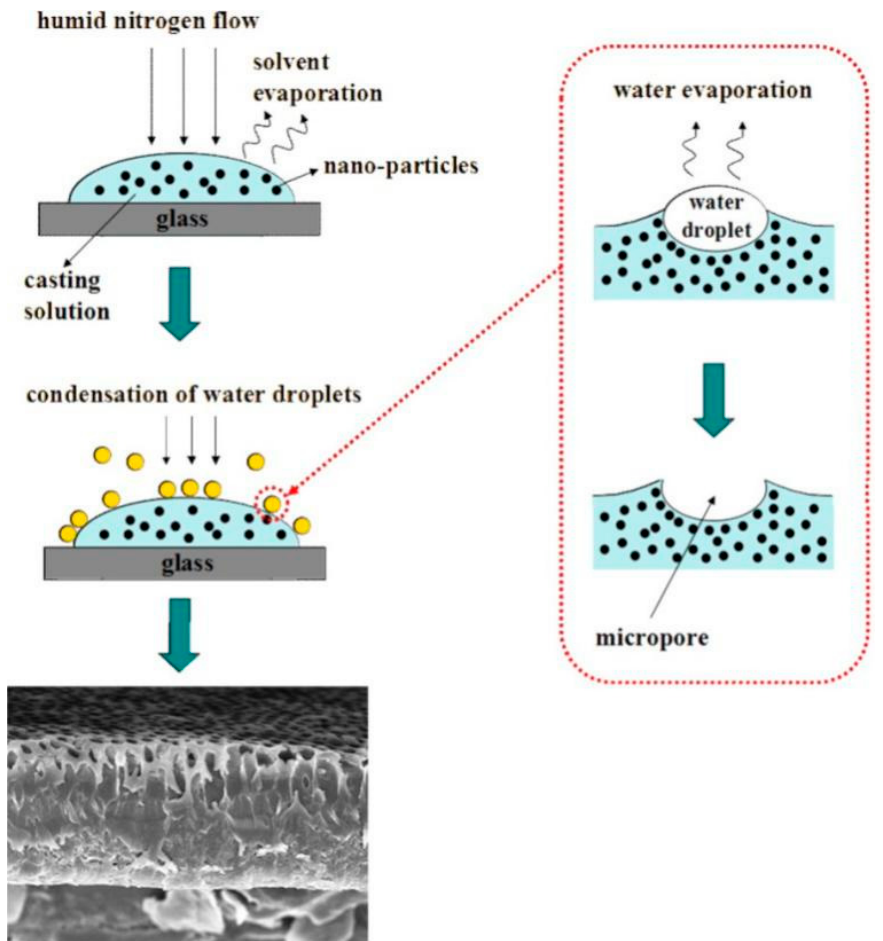
Figure 15. Schematic illustration of the preparation of a MIM by breath figure method. Reprinted with permission from ref [58].